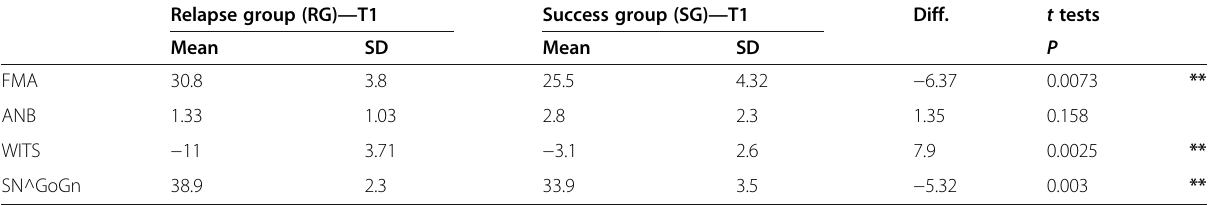
Table 4 Statistical comparisons between groups at T1: cephalometric analysis Relapse group (RG) — T1 Success group (SG) — T1